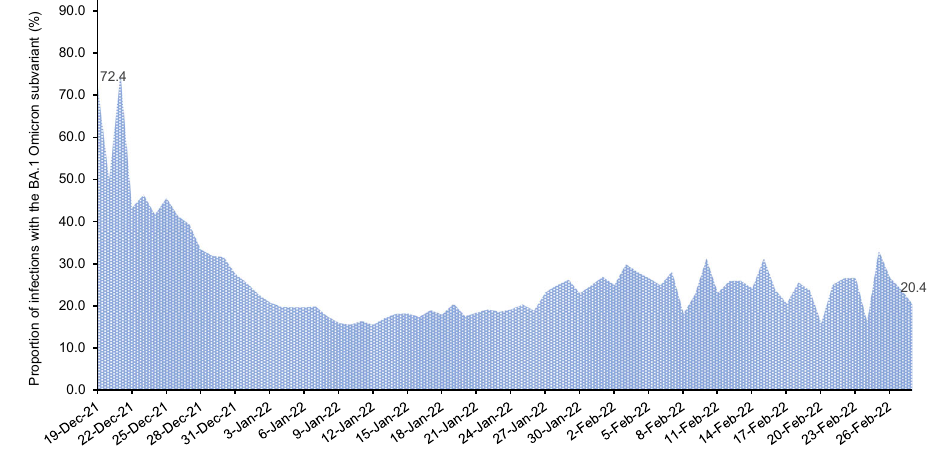
Fig. 1 Distribution of SARS-CoV-2 BA.1 versus BA.2 Omicron infections. Proportion of Omicron infections with the BA.1 (versus BA.2) subvariant in PCR- positive tests assessed using TaqPath COVID-19 Combo Kit during the study